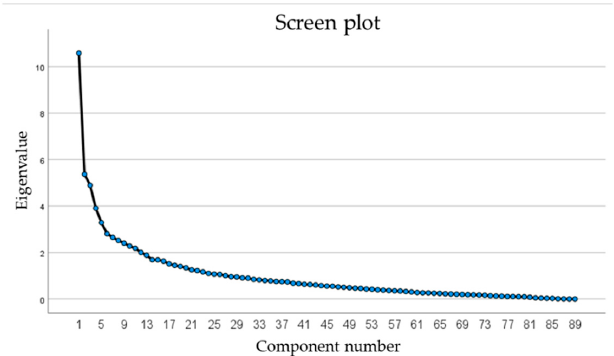
Figure 15. Screen plot rotated solution using the Rotation-Varimax method.